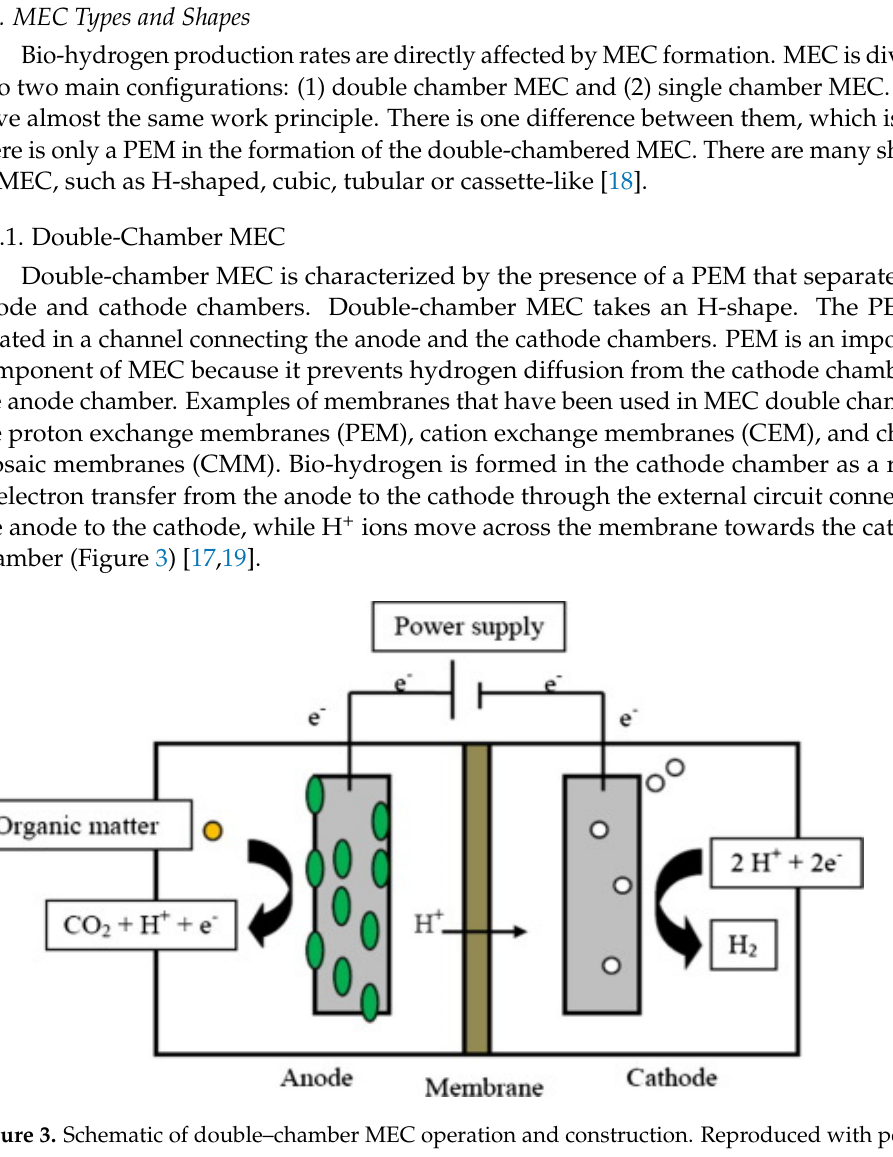
Figure 2. Schematics of ( A ) two–chamber (flat anode) and ( B ) single-chamber membraneless (brush anode) MECs. Reproduced with permission from ref. [16].